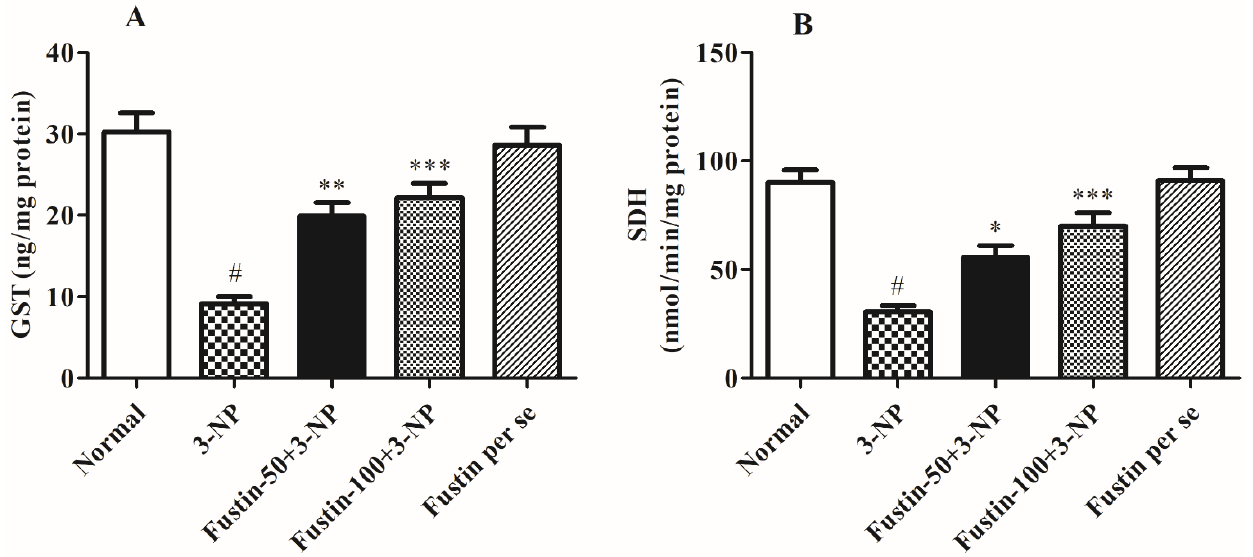
Figure 7. Effect of fustin on enzymatic activity against 3-nitropropionic acid-induced Huntington’s- like effects in rats ( A ) GST, ( B ) SDH. Values are expressed as mean ± S.E.M. ( n = 6). Values are statistically significant at # p < 0.05 vs. negative control group, * p < 0.05 vs. 3-nitropropionic acid, ** p < 0.01 vs. 3-nitropropionic acid, *** p < 0.001 vs. 3-nitropropionic acid, respectively (One-way ANOVA followed by Tukey’s test).